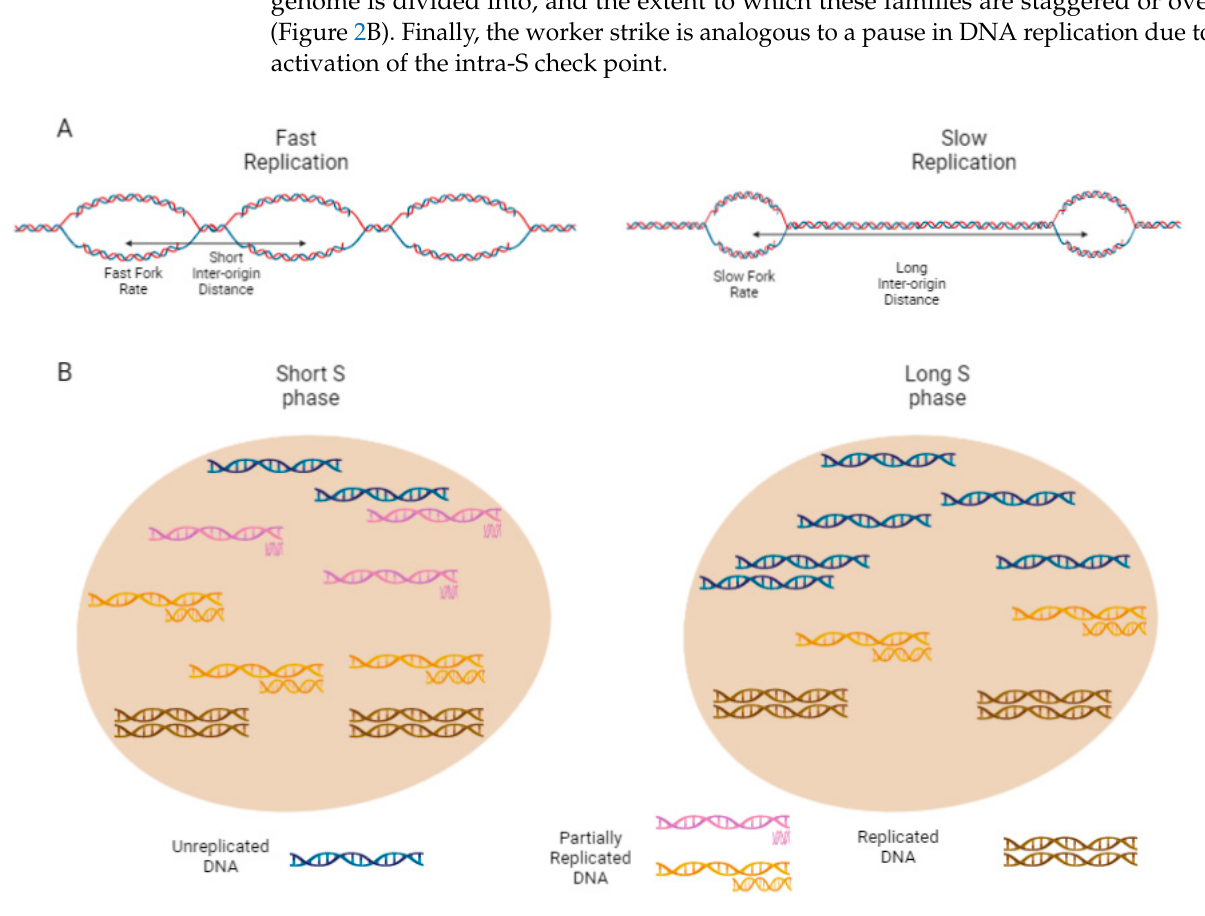
Figure 2. Illustration of factors which can potentially determine S phase duration. ( A ) Local replication rate (LRR). The left DNA replication domain has got a fast fork rate (hence, large replication bubbles), and a high origin density (and therefore short IOD). This means that it has a high LRR and will therefore be replicated quickly. The domain on the right has got a slow fork rate and low origin density. This means that it has a low LRR and will therefore take a long time to be replicated. ( B ) Global replication organization. Each nucleus is a snapshot of the middle of S phase. Each stretch of DNA represents one domain, and the legend and color code are explained at the bottom of the figure. In the left nucleus, the temporal families are big, with 3 domains in orange and 3 in pink. In addition, there is an overlap between the replication of the pink domains that start replicating before the completion of the replication of the orange domains. This demonstrates a short S phase. The nucleus on the right has no overlap of replication and also only has 2 domains per family, both of which mean that S phase will take longer. Figure created with Biorender.com, accessed on 05 April 2022.